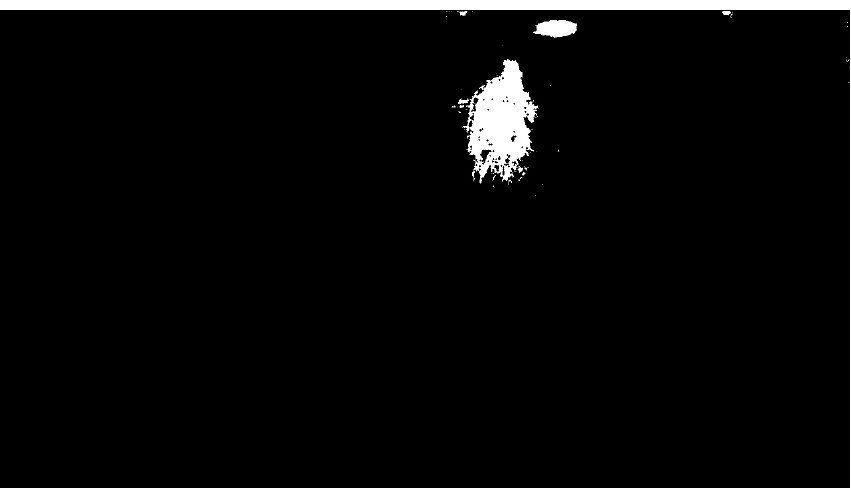
Figure 10. Object